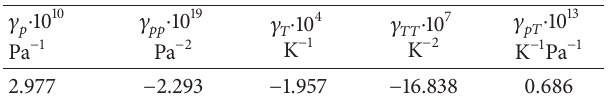
Table 4: Empirical constants used in the drilling fluid density calculation (from Isambourg et al.